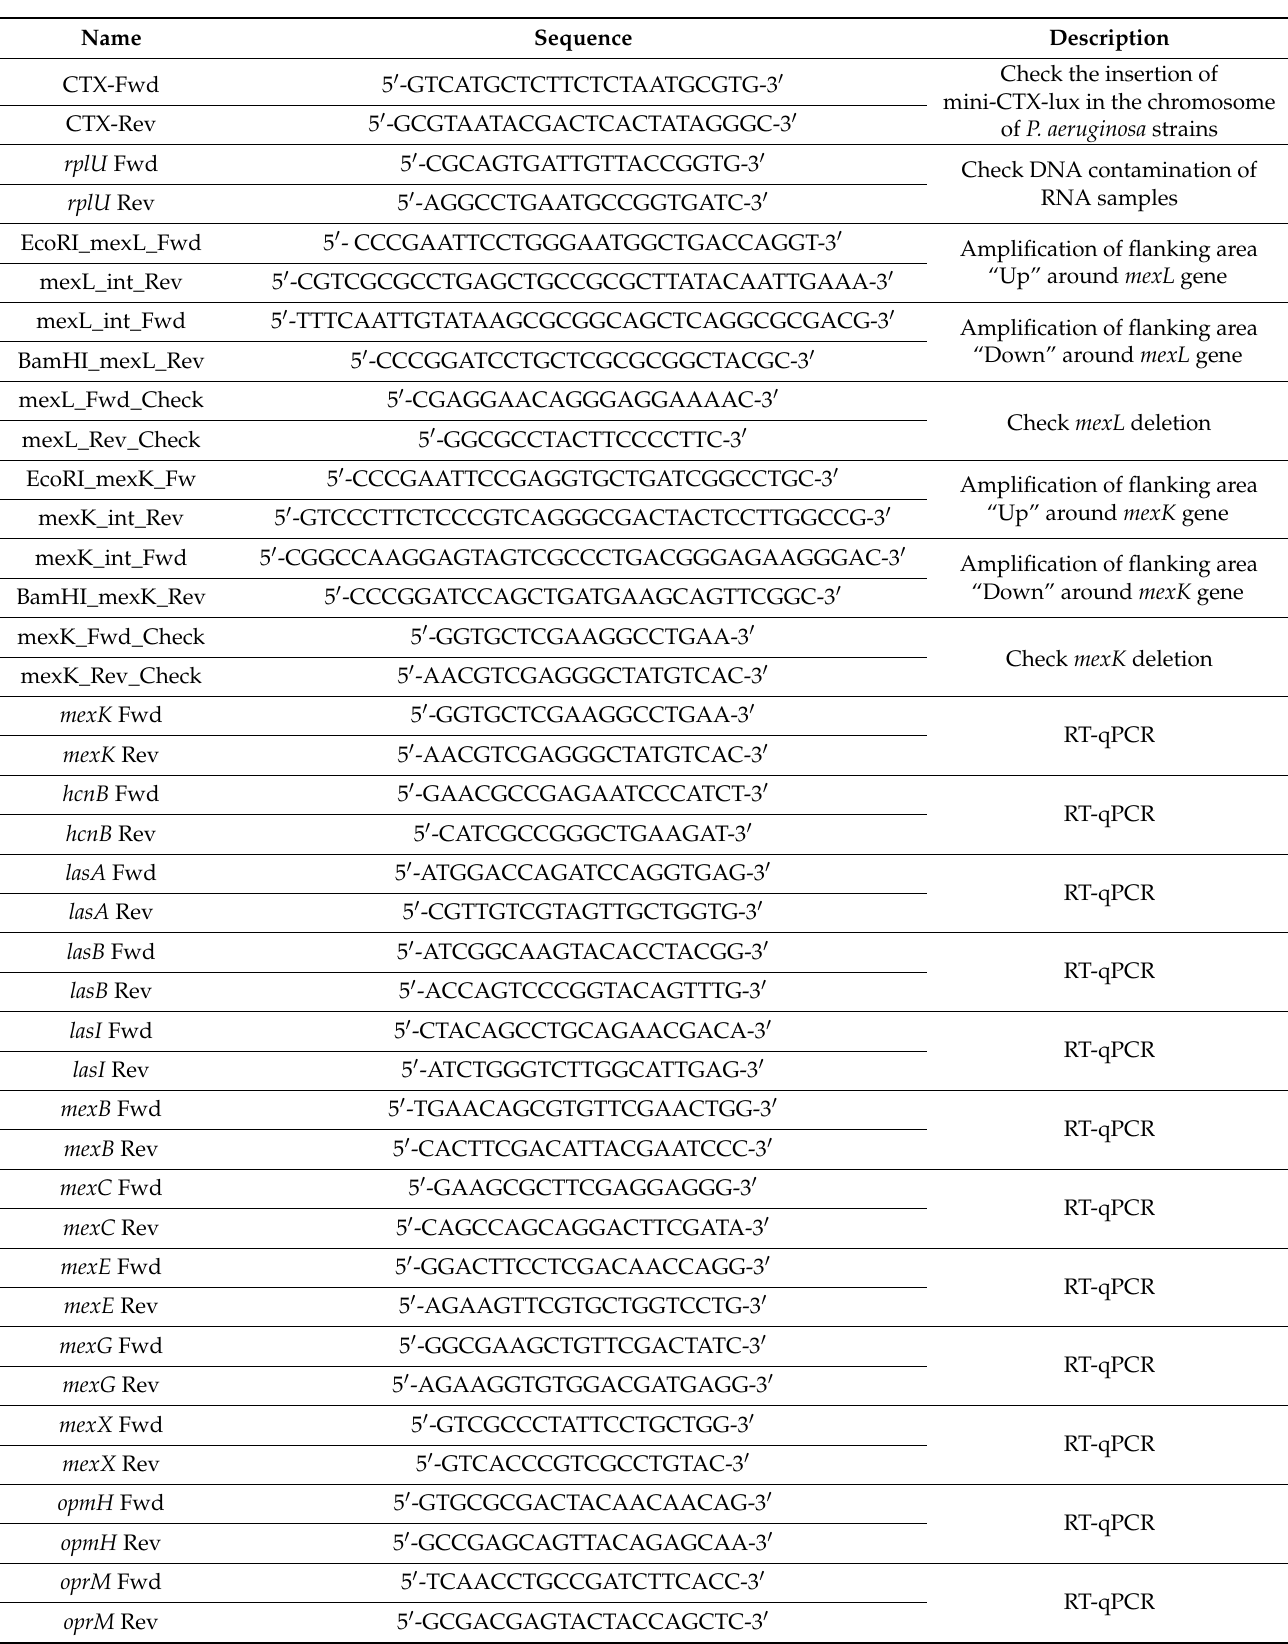
Table 3. Primers used in the present